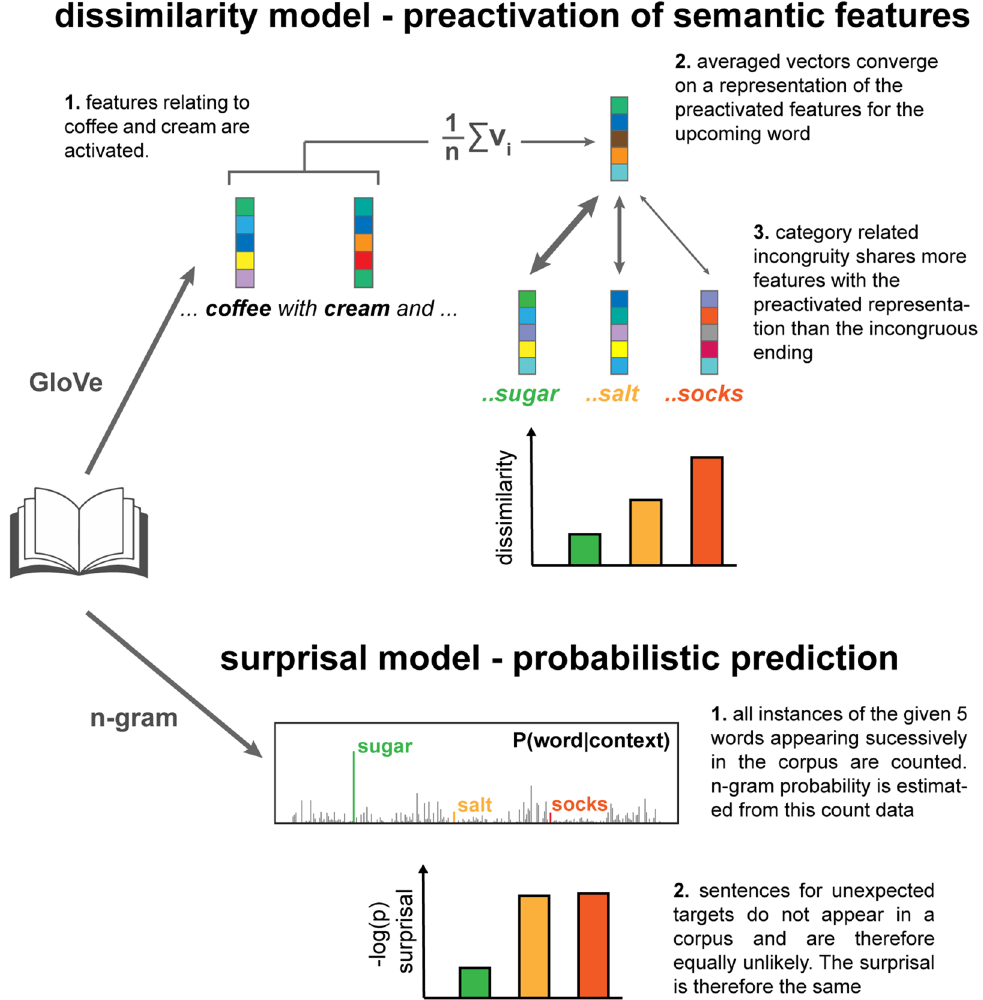
Figure 1. Computational models of predictive processing at lexical and semantic level. To illustrate the idea of prediction operating across multiple representational levels, consider the sentence I take my coffee with cream and… which ends with either an expected completion ( sugar), an unexpected but semantically related completion ( salt ) or an unexpected and semantically unrelated completion ( socks ). At a lexical level, salt is unexpected because it is extremely rare that this sequence of words is heard or read. Processing of this word is therefore assumed to be no different from the processing of other unexpected words (i.e. socks ). Conversely, at a higher semantic level, salt is relatively more likely, because sugar and salt share common features, both being powders and condiments; edible; white etc. We used two models of lexical surprisal and semantic dissimilarity to disentangle the contributions of prediction at lexical and semantic levels, respectively. Top: For the semantic dissimilarity model, vector representations of previous words in the sentence are averaged to form an estimation of the event context. The latent semantic features of the averaged vector converge on a representation similar to the predicted target “sugar” which, consequently, is more similar to words from the same category (e.g. “salt”) than different categories (e.g. “socks”). Bottom: Conversely, the lexical surprisal model does not distinguish between unexpected words based on their semantic category as it only reflects the probability of encountering either sequence of words in the training corpus, which is either rare or